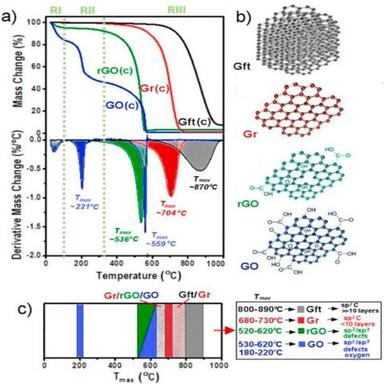
a) TGA and b) DTG graphs from control samples including FLG (Gr (c)), rGO (rGO (c)), GO (GO (c)) and graphite (Gft (c)), showing their typical signatures with characteristic DTG peaks, and peak positions (Tmax), due to their specific structures presented schematically in b). c) Graph presenting Tmax ranges used for the qualitative identification of FLG, rGO, GO and graphite and their key properties. (A colour version of this figure can be viewed online.)